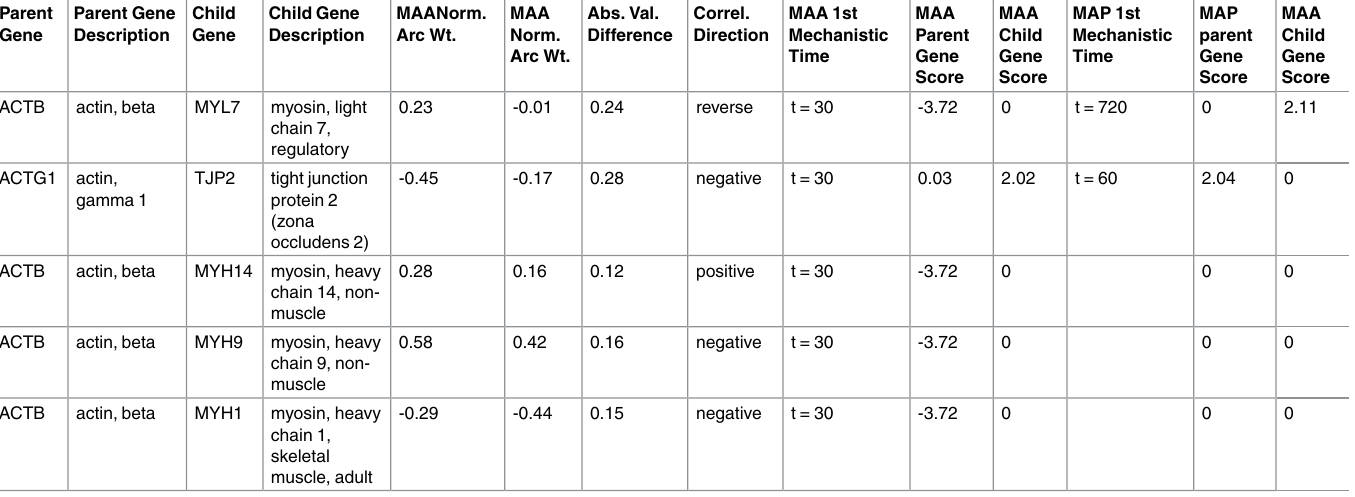
Tight Junction Pathway Bayesian Model Interrogation Results found unique to the MAA